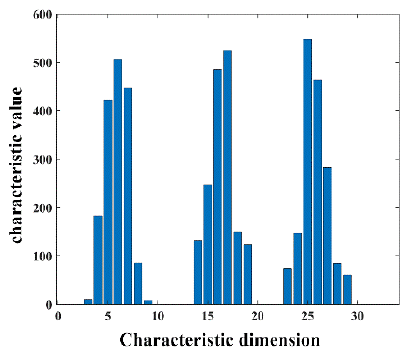
Figure 18. The AGWF feature descriptor for a point.